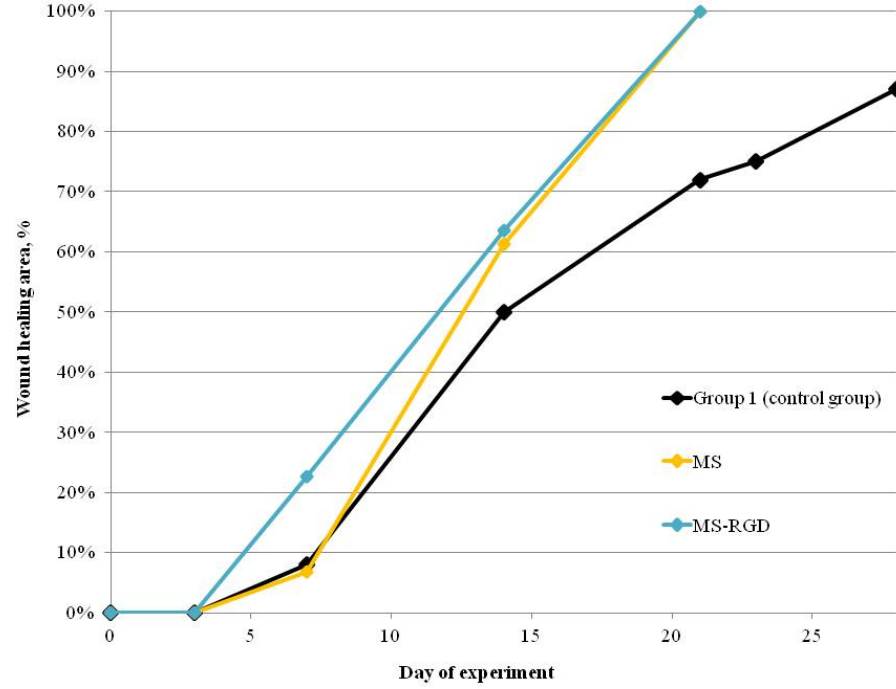
Figure 5. Wistar rat skin healing curves.